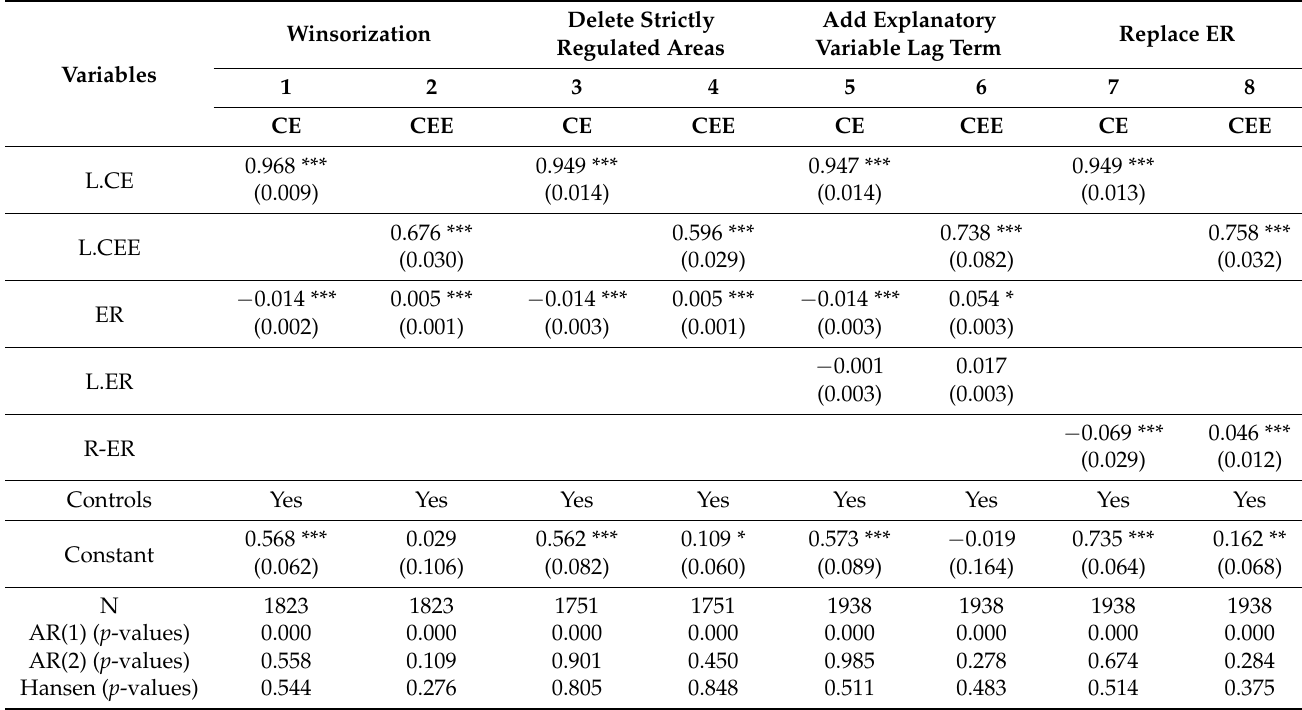
Table 8. Robustness